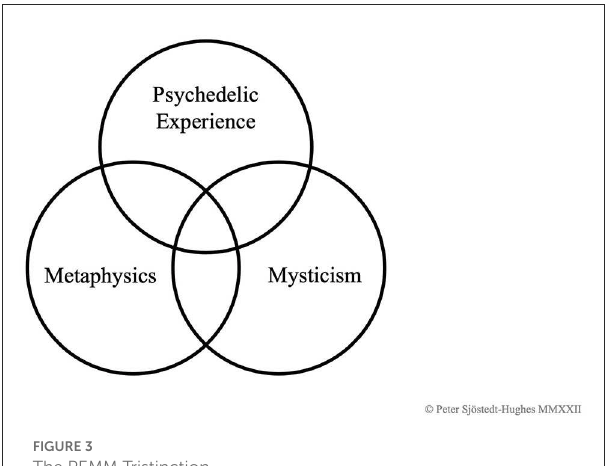
FIGURE3 The PEMM